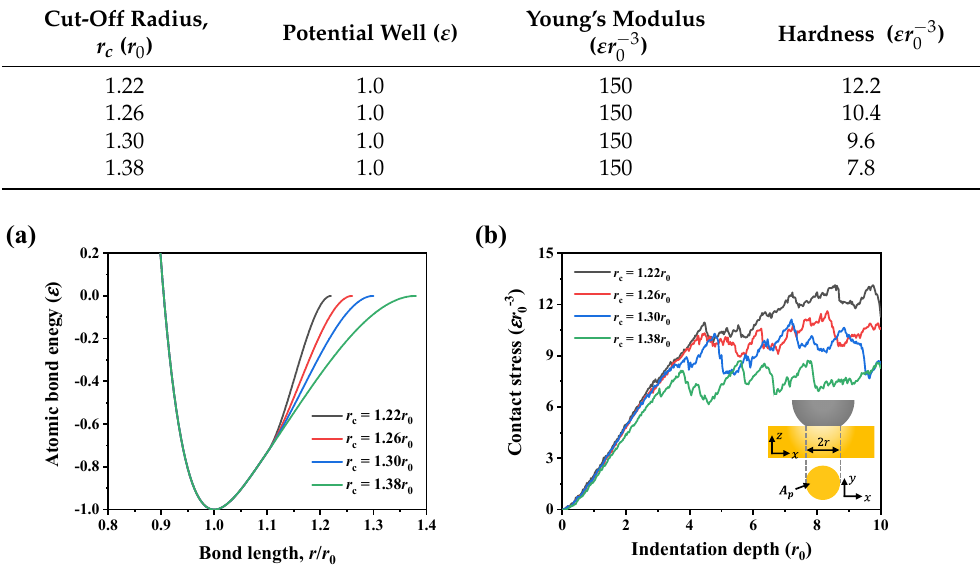
Figure A1. ( a ) The bond energy versus atomic bond length for different cut-off radii r c . ( b ) Contact stress for materials with potentials of different r c ; the inset illustrates the indentation model with an indenter of radius 15 a .